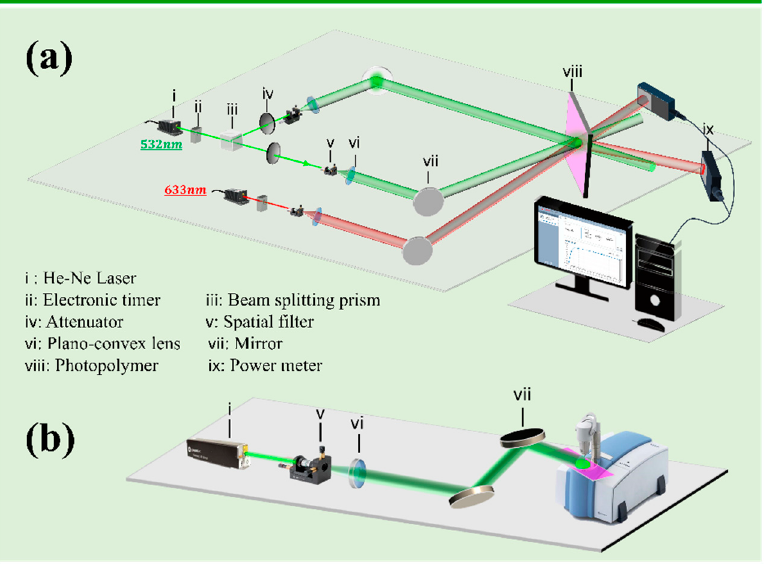
Figure 2. Schematic of experimental test device: ( a ) transmission mode holographic recording setup; ( b ) testing device for real-time infrared spectrum.